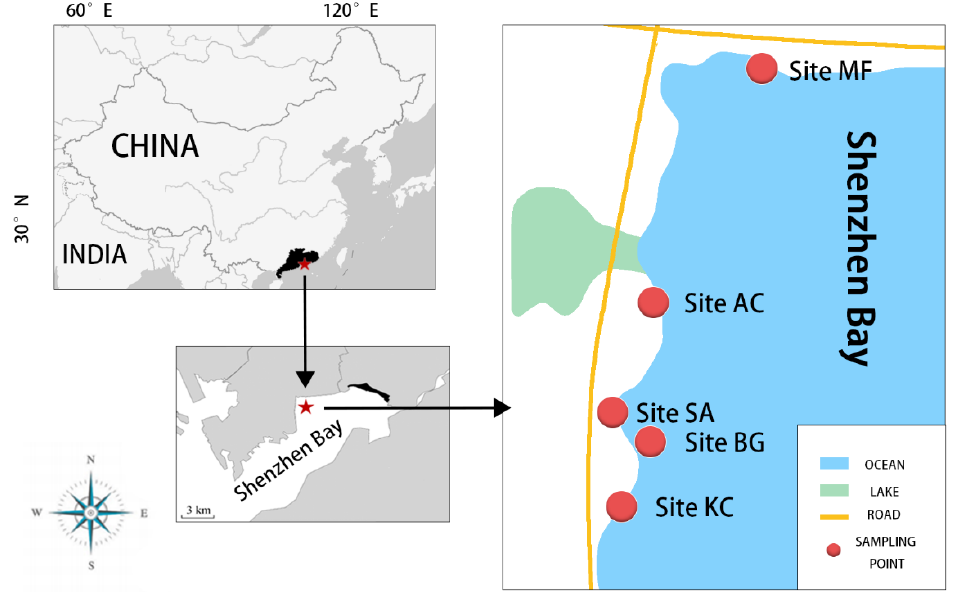
Figure 1. Map showing the research location and sampling sites. KC, BG, SA, AC, and MF are site abbreviations for Kandelia candel, Bruguiear gymnorrhiza, Sonneratia apetala, Aegiceras corniculatum , and mud flats, respectively.